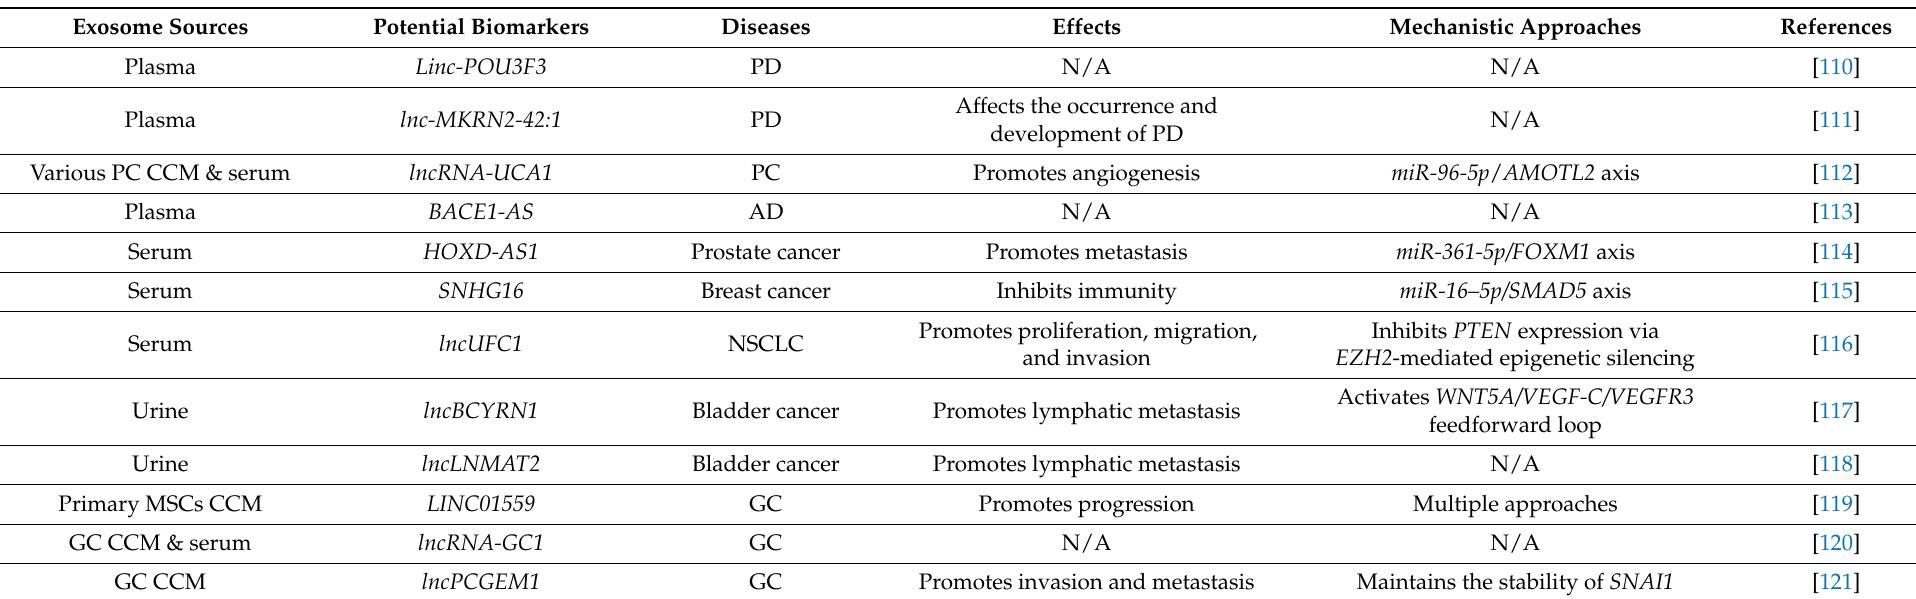
Table 3. Summary of exosomal lncRNAs as potential disease